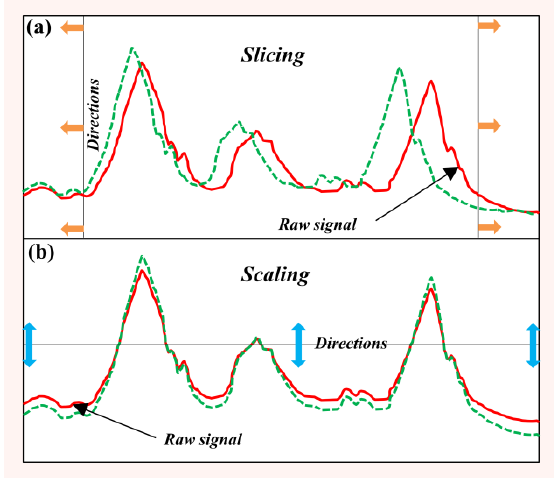
Figure 5. Other time-series data augmentation techniques.